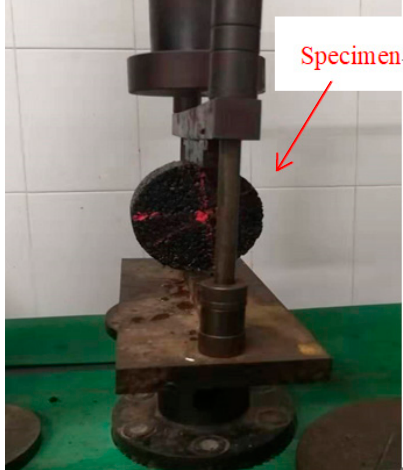
Figure 5. Freeze-thaw splitting test.